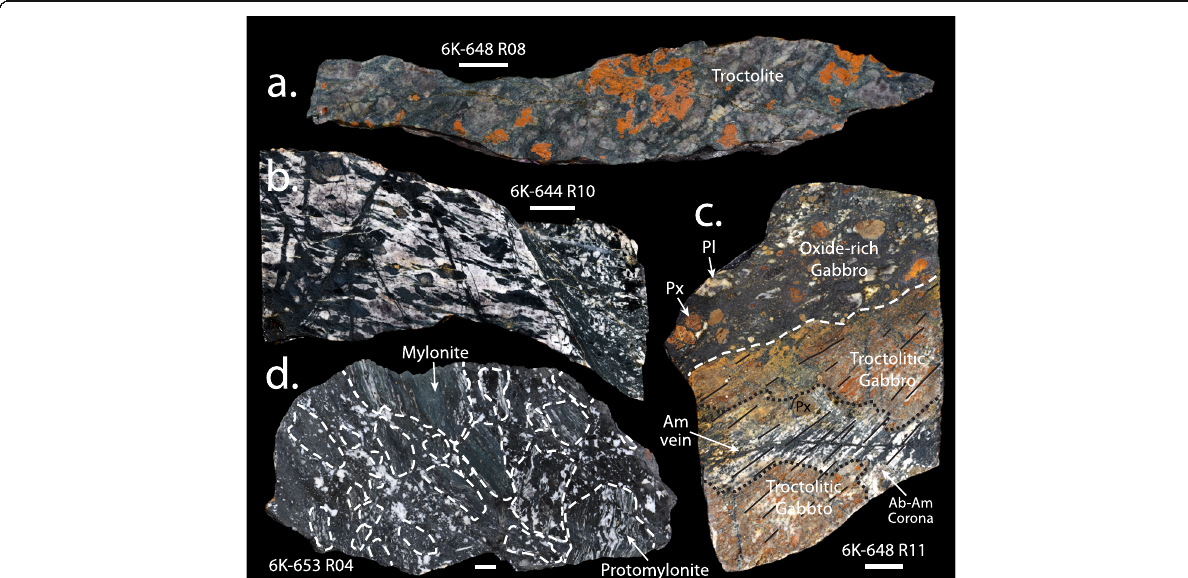
Fig. 32 Selected samples collected from the eastern Atlantis Bank high-angle normal fault face at 57° 21 ′ E (Fig. 29): a Coarse-grained spinel- bearing troctolite with Mg# 88 – 90 augite. Approximately 50% of the olivine is replaced by actinolite and chlorite, and the rest by bright orange clay. b Amphibolite facies olivine gabbro with near 100% replacement of mafic minerals by undeformed black hornblende. c Porphyroclastic oxide-rich gabbro in an oxide-rich shear zone crosscutting a foliated troctolitic gabbro. Foliation traced by thin black lines whereas the contact is traced by the long-dashed white line. There is a ~ 2 cm-wide amphibole-albite alteration halo in the troctolitic gabbro around a crosscutting millimeter-thick black amphibole vein offsetting the foliation by ~ 1 – 2 mm. The olivine gabbro augite is the light gray to silvery mineral whereas the olivine is oxidized to orange clay. d Cataclasite consisting of angular fragments of gabbro amphibolite gneiss, with clasts ranging from protomylonite to mylonite, outlined by dashed white lines, in an undeformed recrystallized matrix of fine- to medium-grained amphibole and plagioclase replacing gabbro cataclasite from near the foot of the eastern, high-angle, normal fault